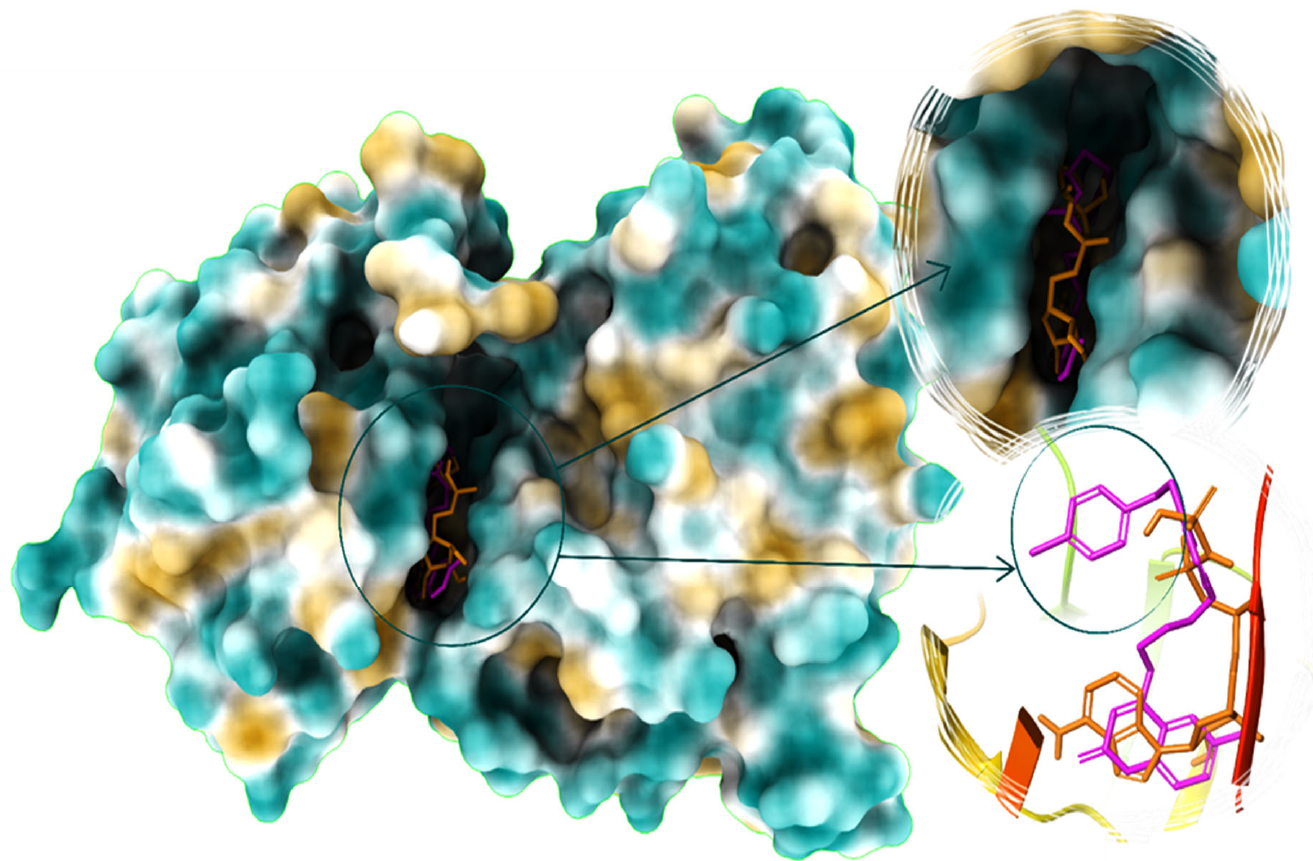
Figure 6. Binding pose of the PC-12 ( magenta ) and the co-crystal ligand ( orange ) inside the binding pocket of JNK3.